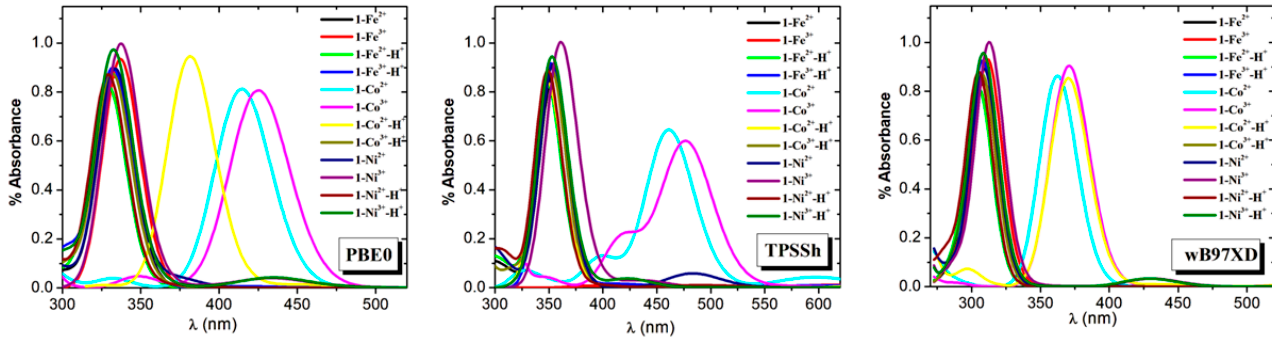
Figure 5. Percentage absorbance vs wavelength for the calculated minima in THF solvent.